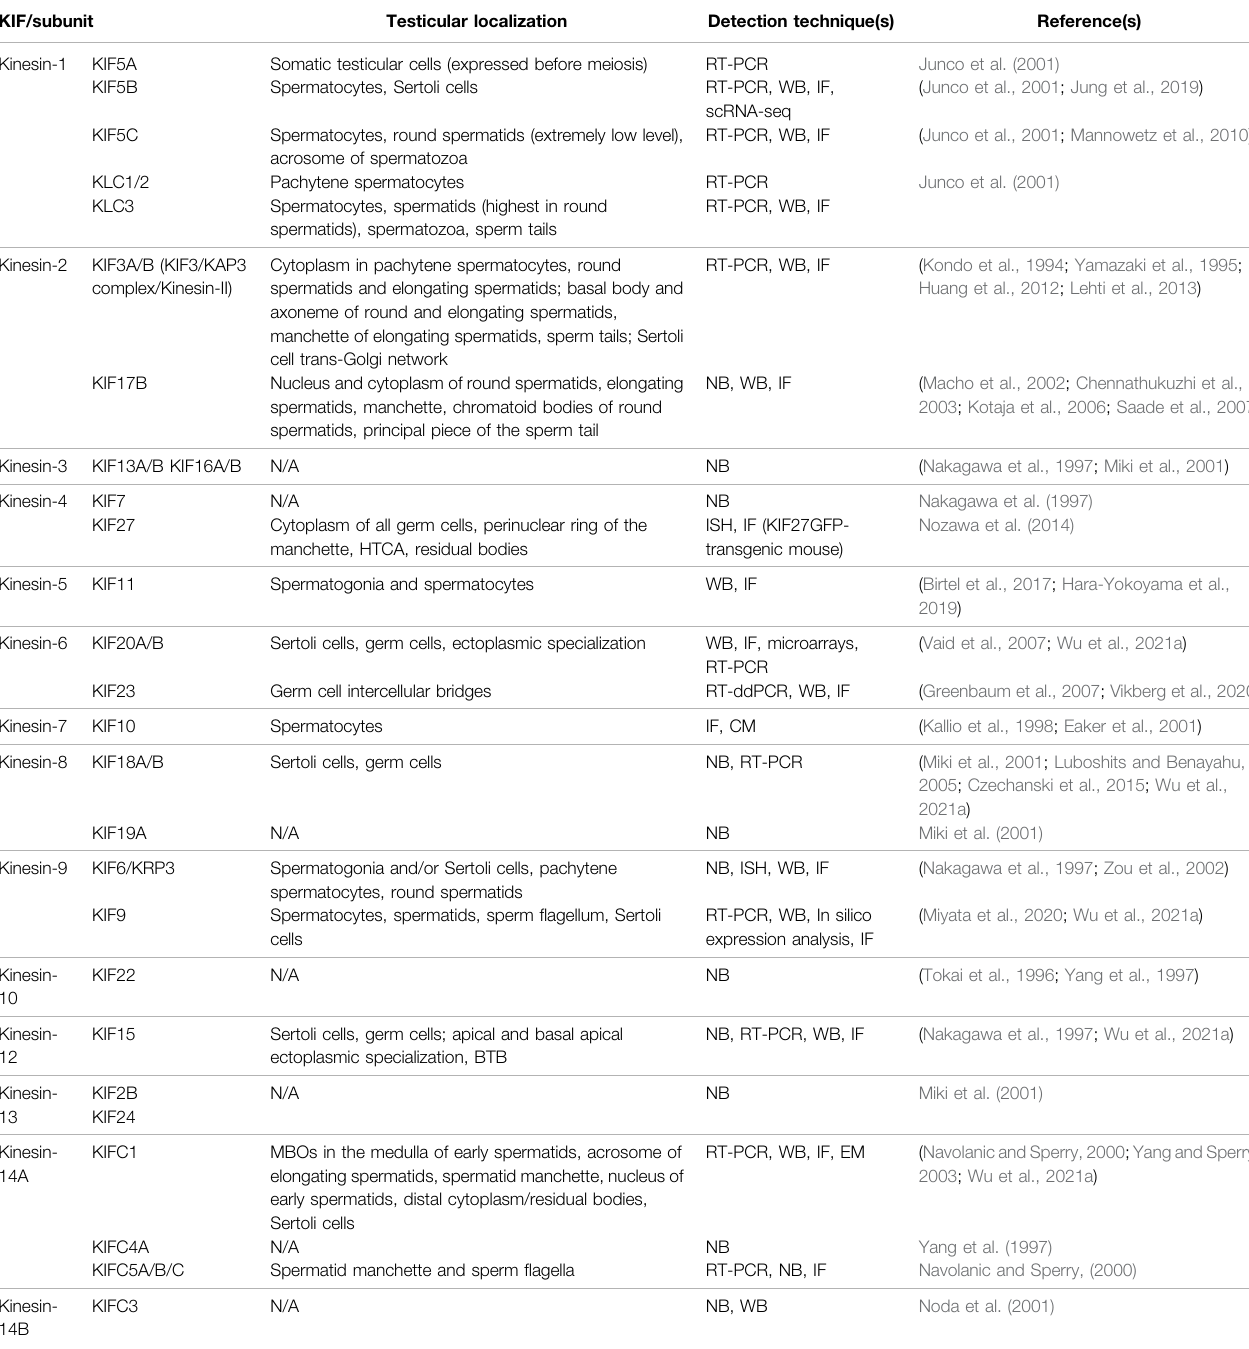
TABLE 1 | KIFs discovered in rodent